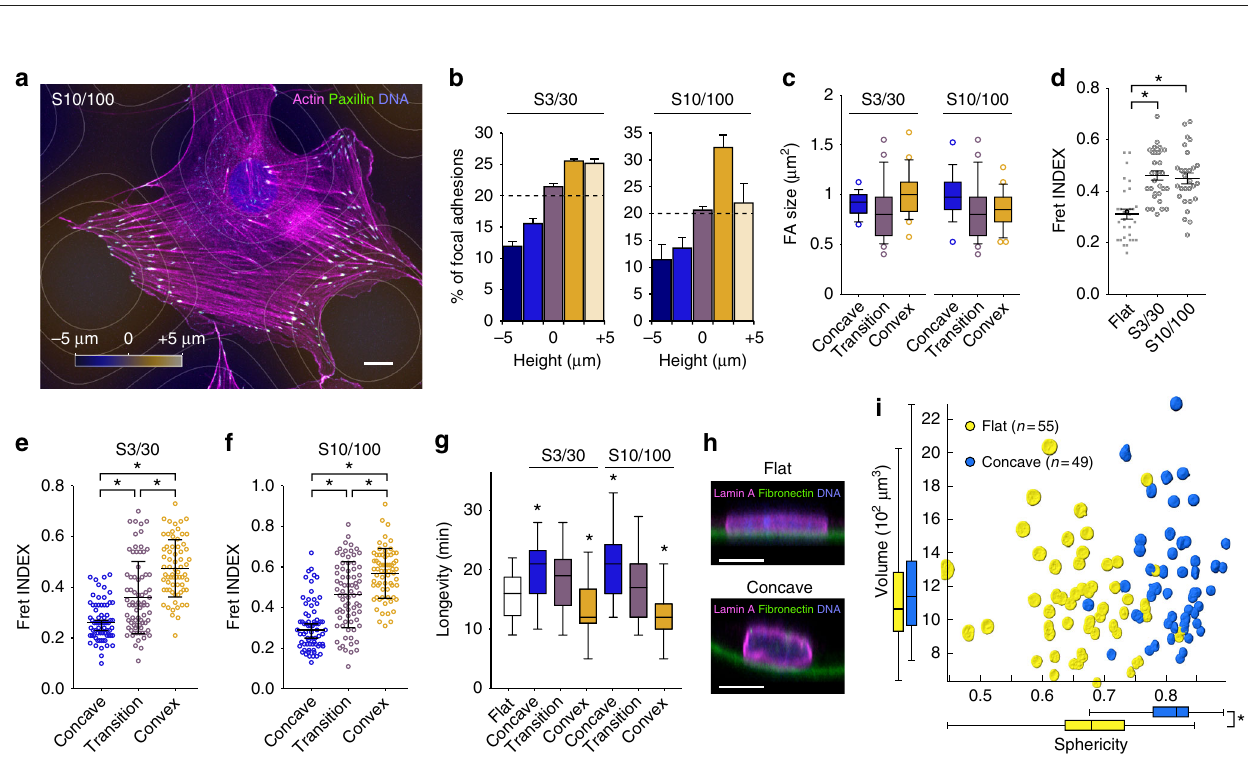
Fig. 3 Curvotaxis allows adherent cells to avoid convex hills during their migration. a , b , g , h Cells labeled with cell tracker adhering on S3/30 ( a ) or S10/ 100 ( g ) surfaces and the distribution of their nuclei according to surface topography at the indicated time points ( b and h ). Nuclei are highlighted in red. c Tracking of nuclei on a S3/30 surface. Arrowheads indicate movement direction. d Tracking of a single nucleus over the same period. Positions are highlighted in red. e Average speed of nuclei according to surface height. f , q Tracking of cells and nuclei barycenters of cells moving on sinusoidal substrates. i , j Cell tracking at early (30 min – 4 h 30 min) or late stages (16 – 20 h) of the interaction with the surface (*dodging event, **stopping event, ***migration through cols). k Distance between nuclei and surface minima over time, at early or late stages of the interaction. l Apparent nuclear size of cells adhering on S10/100 at the indicated time points. m – p Cells stained for DNA and actin on a S10/100 surface ( m ) and the height distribution of corresponding signal intensities ( n ), nuclei positions ( o ), and density of nuclei on fl at, concave, or convex curvatures ( p ). Error bars in b , h , and o represent the standard error of the mean of three independent experiments. Error bars in e and i represent the standard deviation from the mean. The total number of cells is indicated for each condition. Scale bars: 100